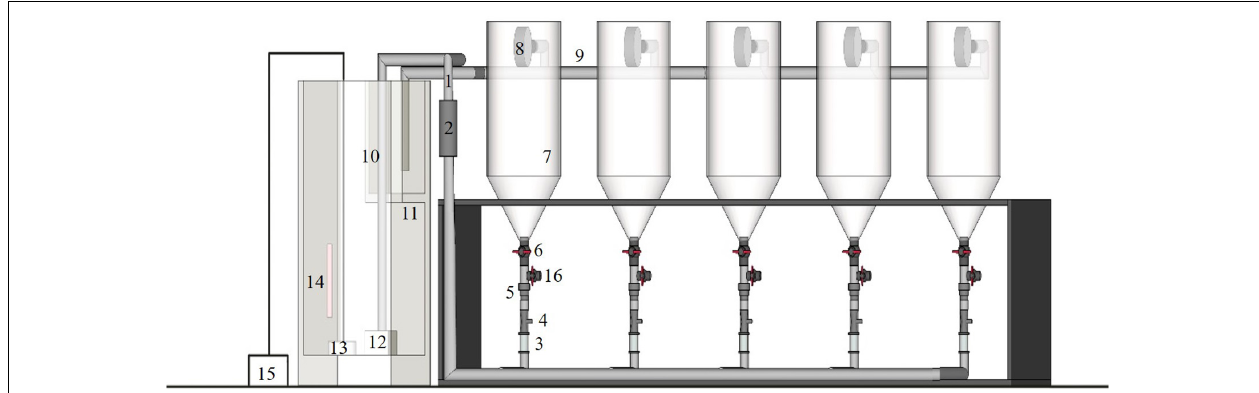
FIGURE 1 | Experimental RAS configuration: (1) inlet pipe; (2) ultraviolet disinfection lamp; (3) flow meter; (4) venturis; (5) one-way valves; (6) valves; (7) transparent cone container; (8) filter drums; (9) drain pipe; (10) filter tank; (11) filter partition; (12) water pump; (13) aeration disk; (14) thermostat; (15) air pump; (16)